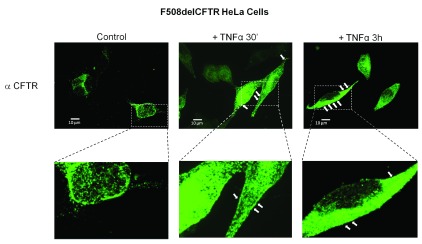
Localization of F508del-CFTR in HeLa cells.HeLa cells stably transfected with F508del-CFTR were subjected to CFTR immunodetection and analyzed by confocal microscopy (scale bar = 10 µm). Untreated cells (left panels). Cells treated with 50ng/ml TNFα for 30 min (middle panels). Cells treated with 50ng/ml TNFα for 3–6h (right panels). White arrows show a possible membrane localization of F508del-CFTR.